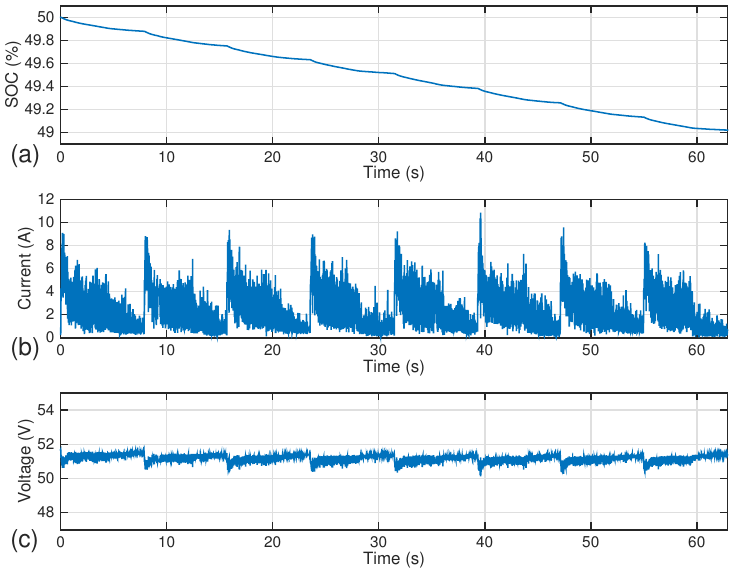
Figure 10. Battery-only simulation results for medium-SOC. ( a ) SOC, ( b ) battery current, ( c ) battery